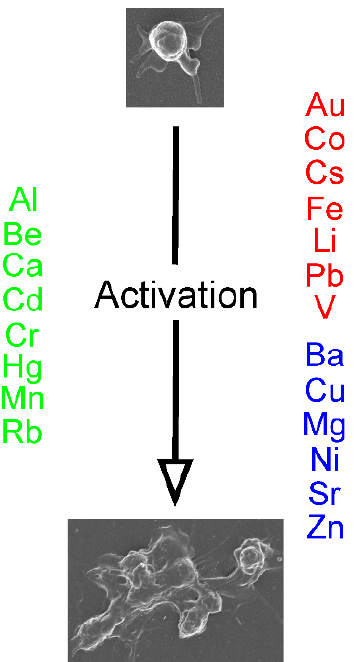
Figure 2. Effects of metals on platelet activation. Metals depicted in green enhance activation, those displayed in red decrease activation, and elements that are blue have conflicting effects on platelet activation that may be concentration-dependent or dependent on the species source of the platelets.